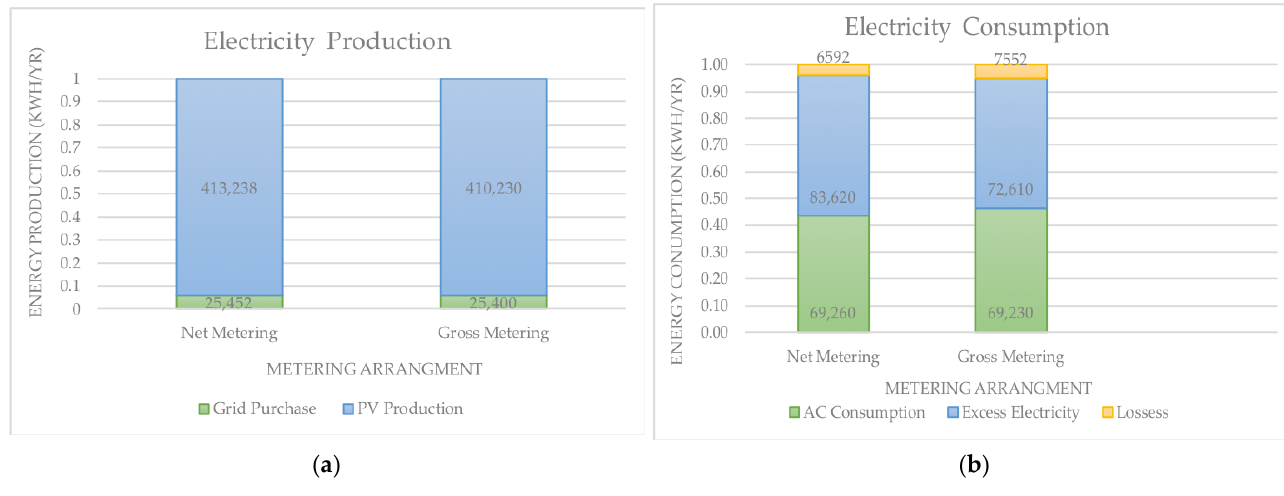
Figure 7. ( a ) Electricity Production (kWh/yr); ( b ) Electricity Consumption (kWh/yr). Table 11. Energy Production and Energy